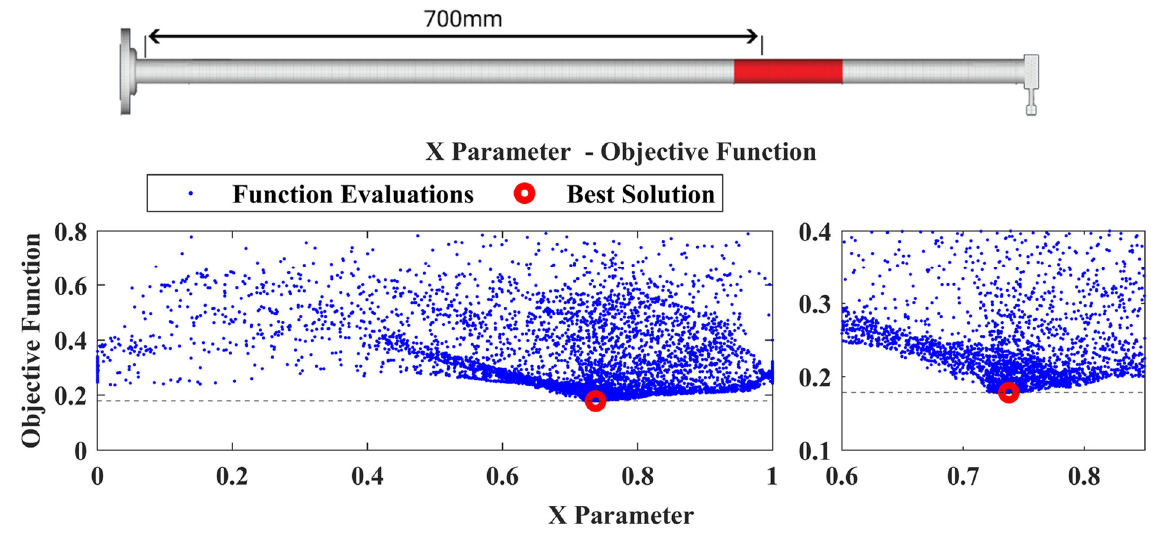
Figure 20. Damaged FE Model along with the location parameter X versus the Objective Function value of Case 1.